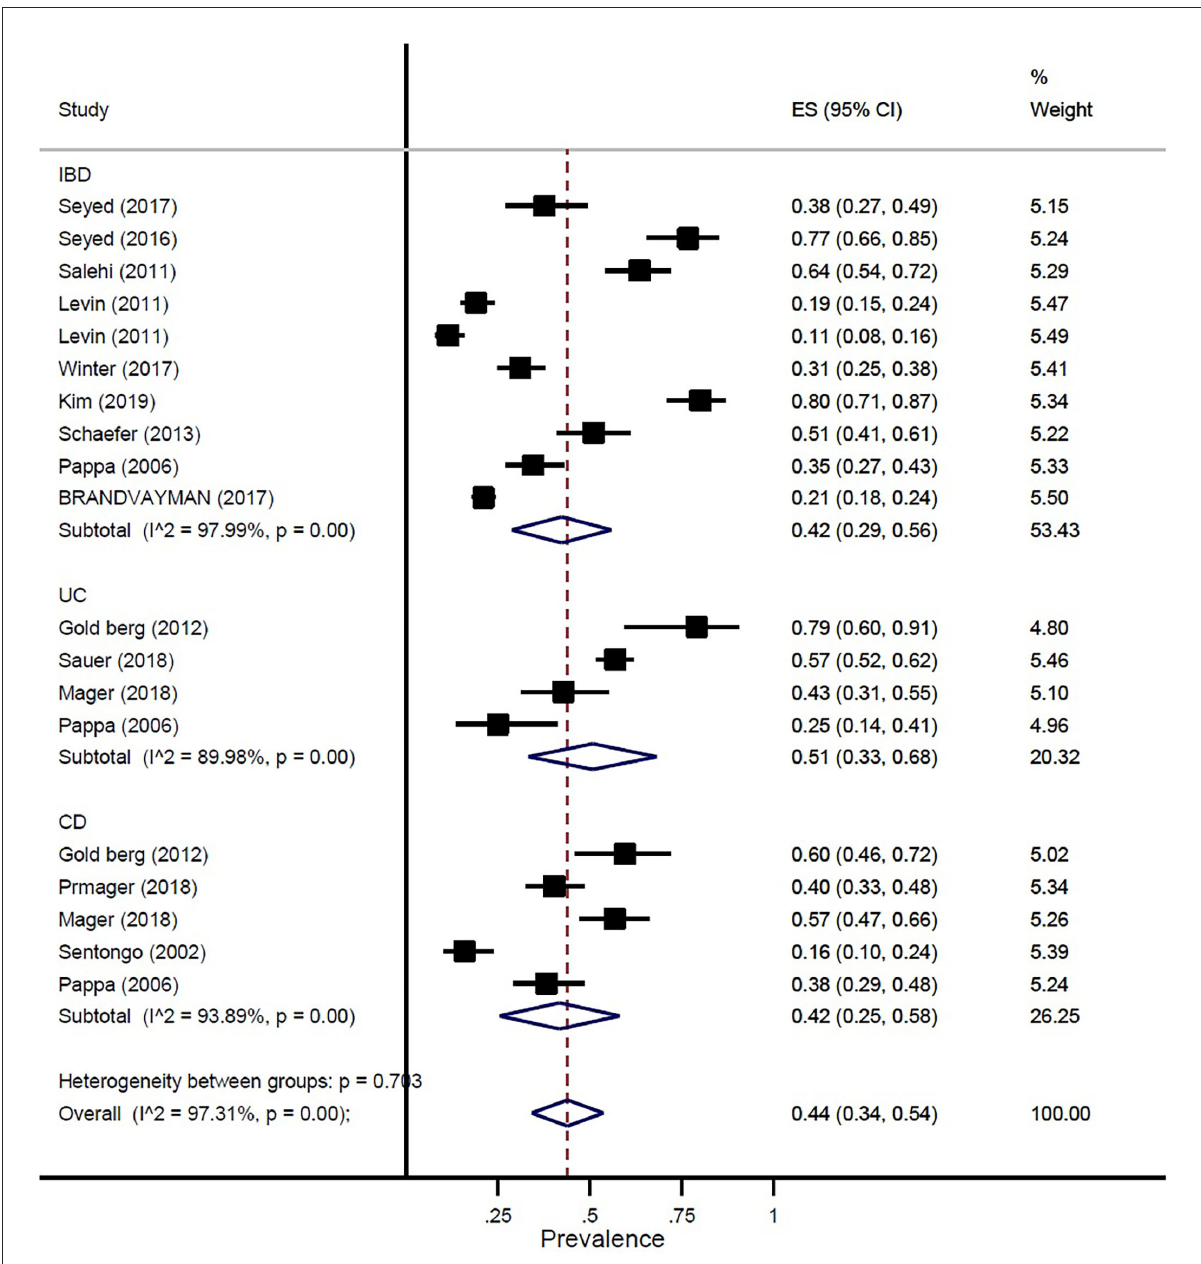
FIGURE3 Pooled estimate of the prevalence of vitamin D deficiency or insufficiency in children and adolescence with IBD, UC, and CD.